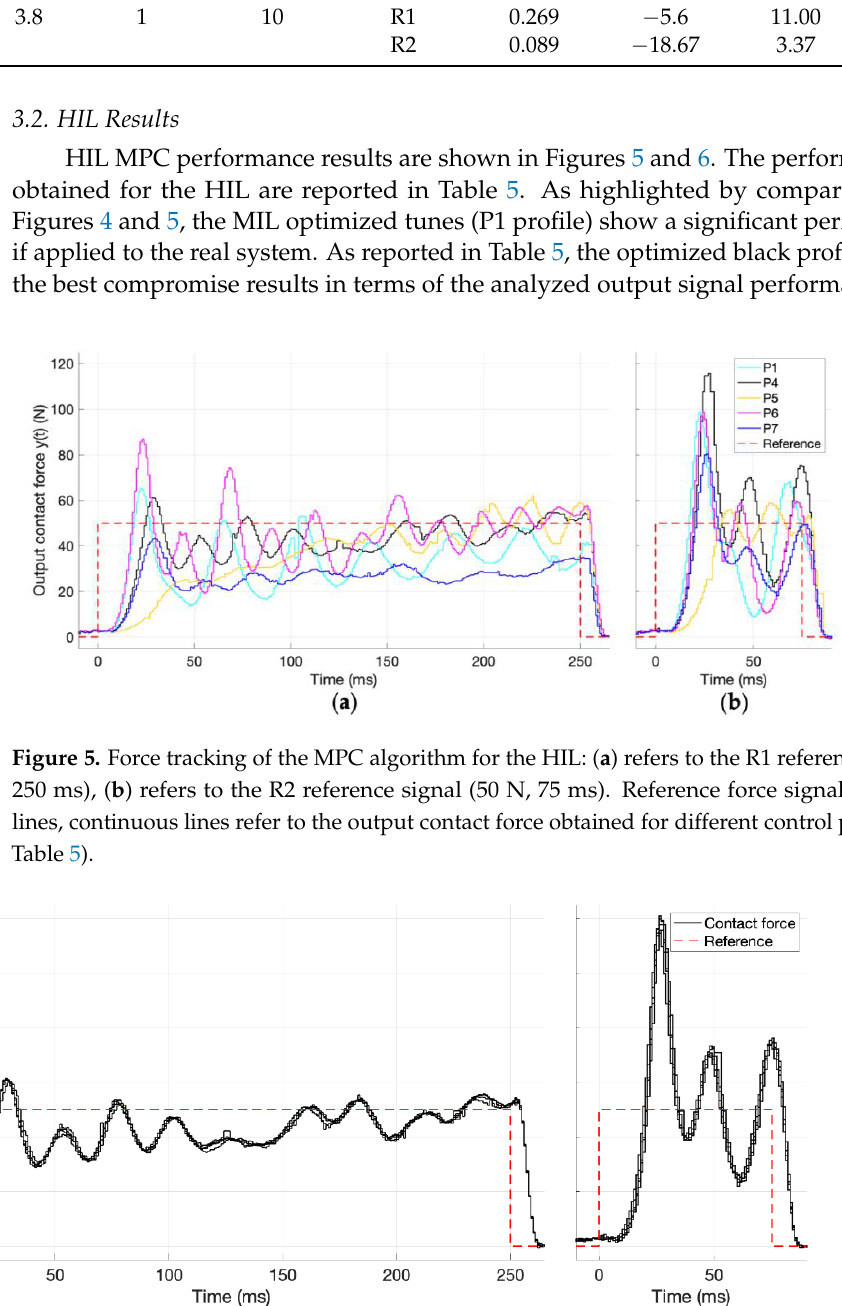
Figure 6. Force tracking of the MPC algorithm for the HIL: ( a ) refers to the R1 reference signal (50 N, 250 ms), ( b ) refers to the R2 reference signal (50 N, 75 ms). Reference force signal in red dashed lines, continuous lines refer to five consecutive force signals obtained for a particular selection of control parameters (see Table 5, P4 profile).